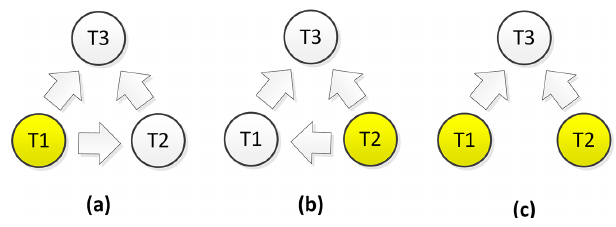
Figure 11. Wildfire-induced domino effect scenarios. (a) T1 catches fire as it is exposed to the heat of the wildfire, and triggers secondary fires at T2 and T3 via a domino effect. (b) T2 catches fire as it is exposed to the heat of the wildfire, and triggers secondary fires at T1 and T3 via a domino effect. (c) Both T1 and T2 catch fire as they are exposed to the heat of the wildfire, and trigger a sec- ondary fire at T3 via a domino effect. Tanks directly impacted by the wildfire have been highlighted